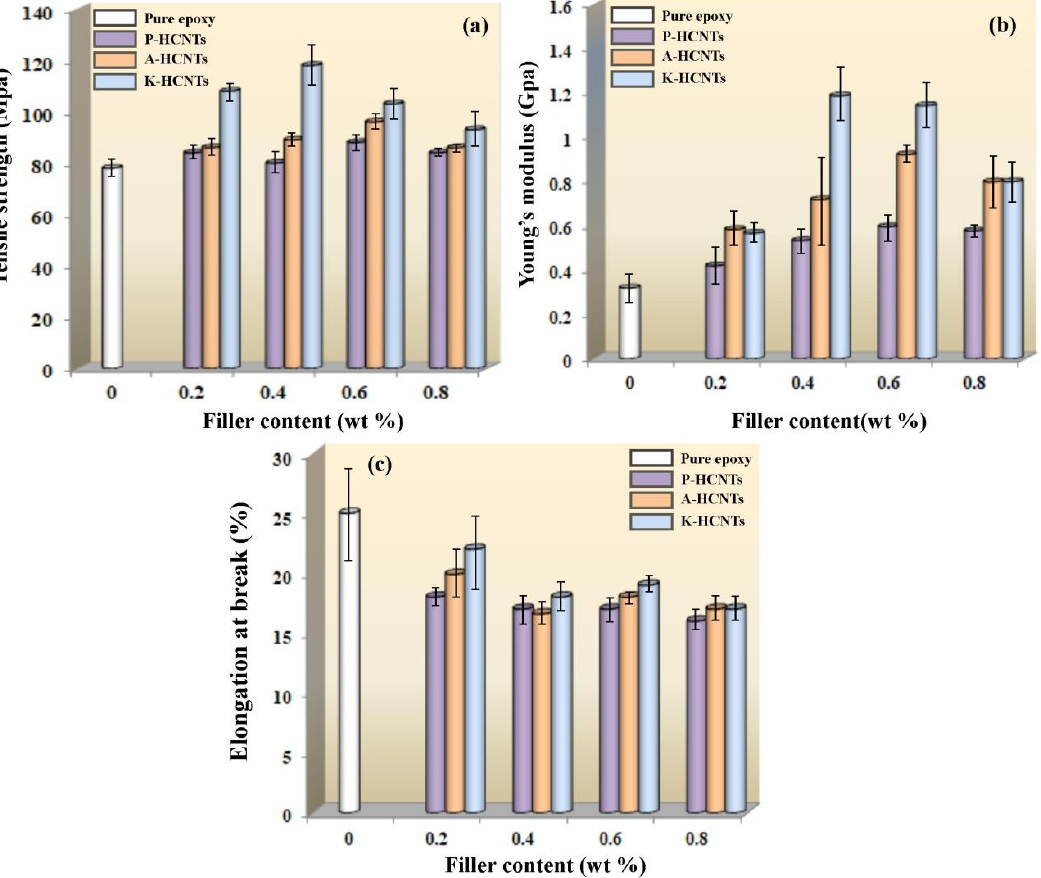
Figure 6. Tensile strength ( a ), Young’s modulus ( b ) and elongation at break ( c ) of pure epoxy, untreated HCNT/epoxy and surface-treated HCNT/epoxy composites.